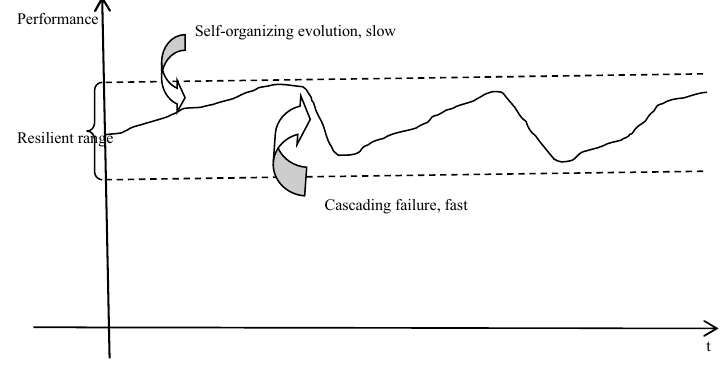
Figure 4. The resilience of supply network (SN) based on SOC.